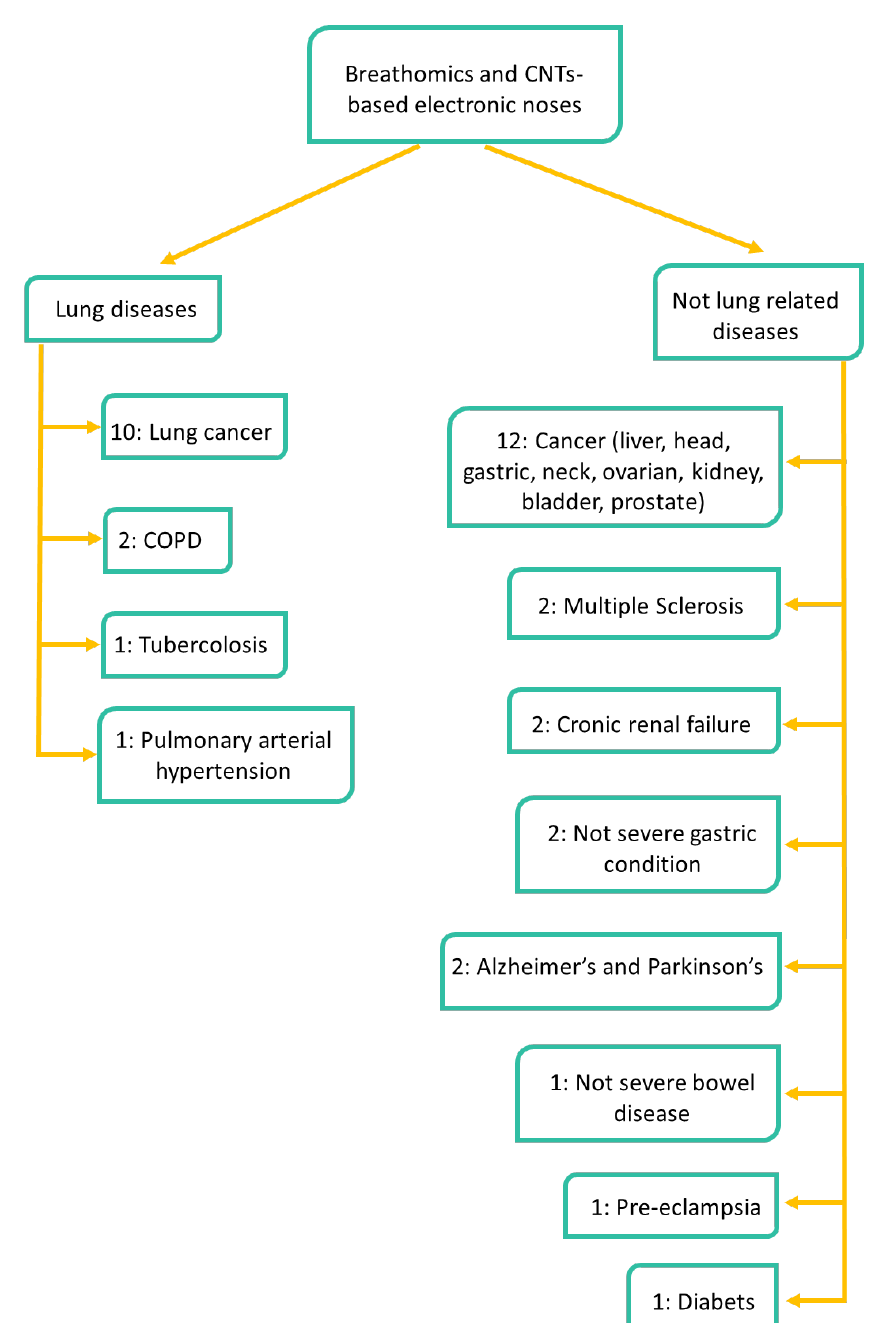
Figure 7. Flow diagram summarizing the pathologies investigated by the 26 articles reporting on CNTs-based electronic noses. Of note, the sum of the papers dealing with all pathologies is larger than 26, since some articles investigate more than one disease.